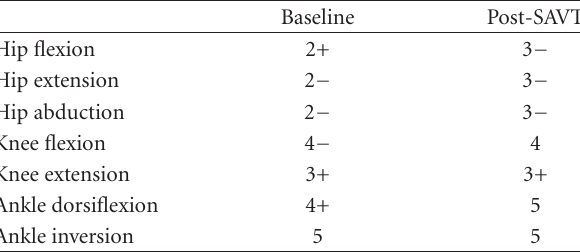
Table 2: Baseline and post-SAVT muscle